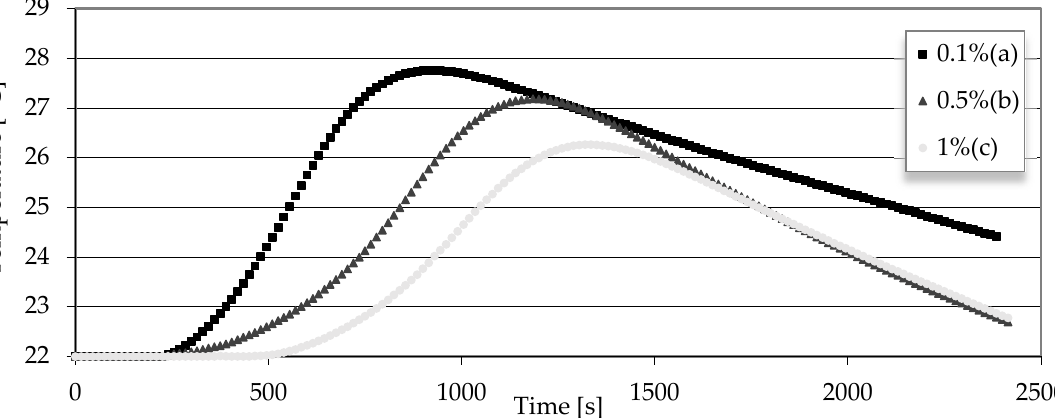
Figure 3. Dependence of reaching the maximum temperature and hardening time of gypsum samples with polymer (a) 0.1%, (b) 0.5% and (c) 1%.